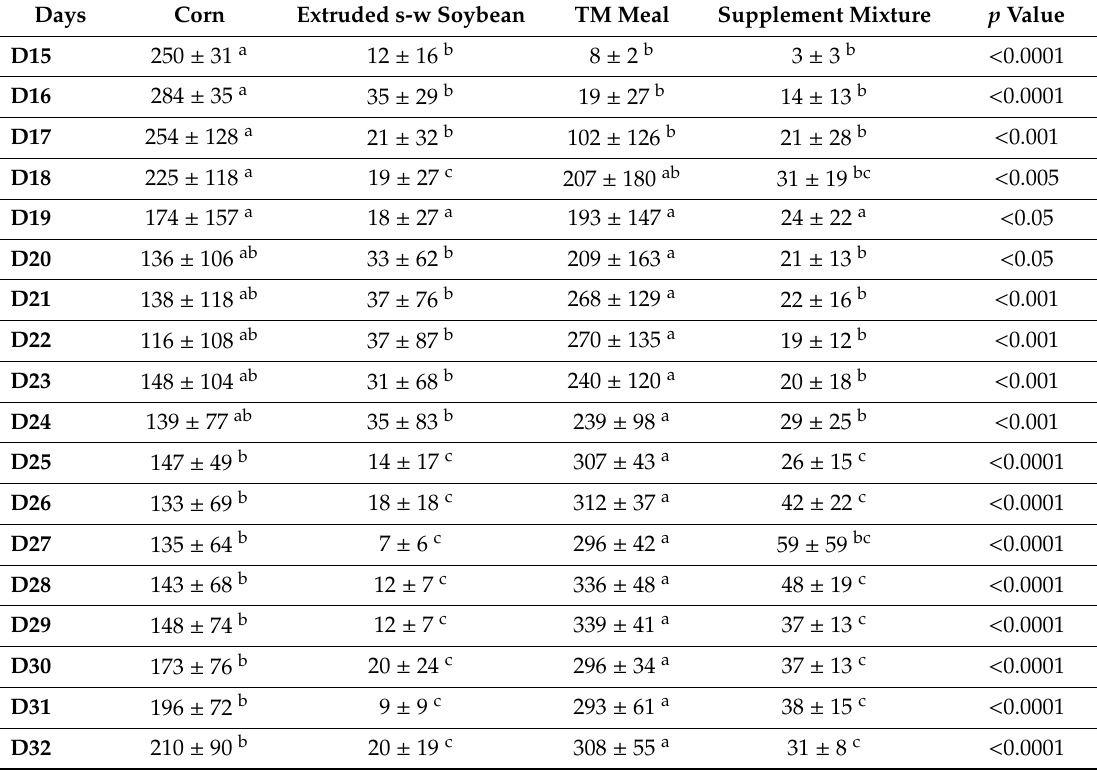
Table 5. Daily consumption of ground corn, extruded semi-whole soybean, T. molitor (TM) meal, and supplement mixture of the test group from day 15 to day 32, data in grams per pen (five chickens) ± standard